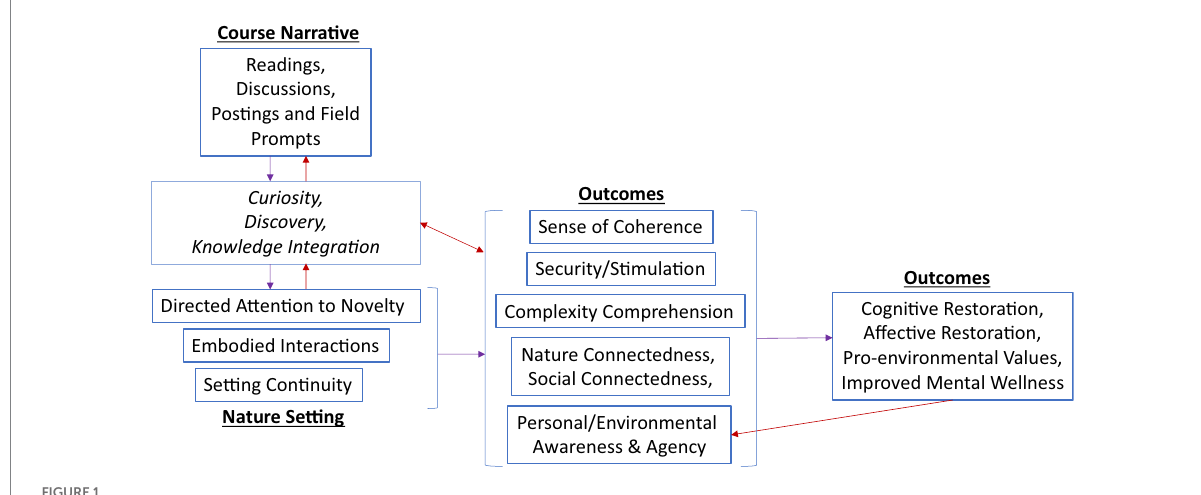
FIGURE 1 Self-reported outcomes of embodied and purpose-directed attention to a nature